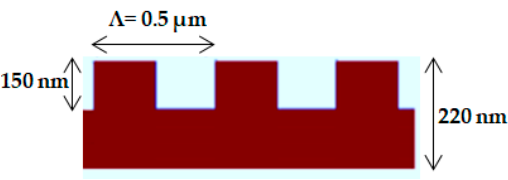
Figure 2. Grating structure dimensions.